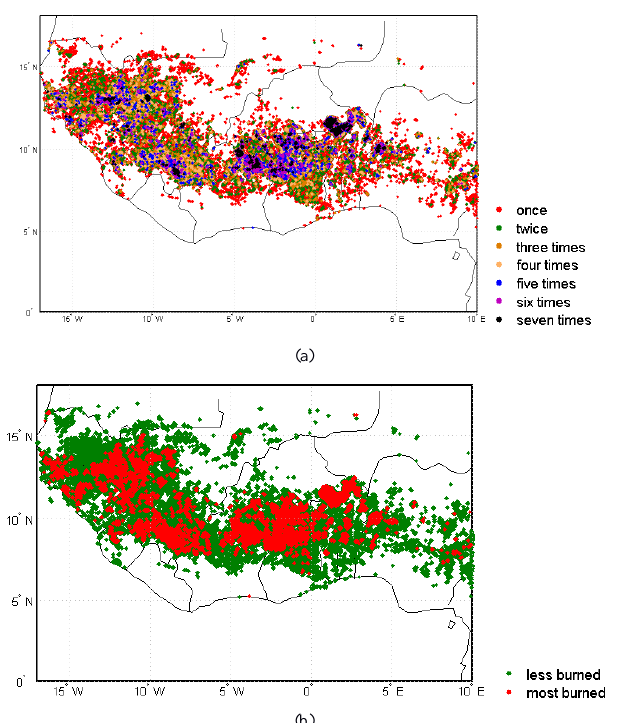
Figure 6. (a) Number of the times that the same pixel has been burned over the study period. (b) Map of the most burned pixels (in